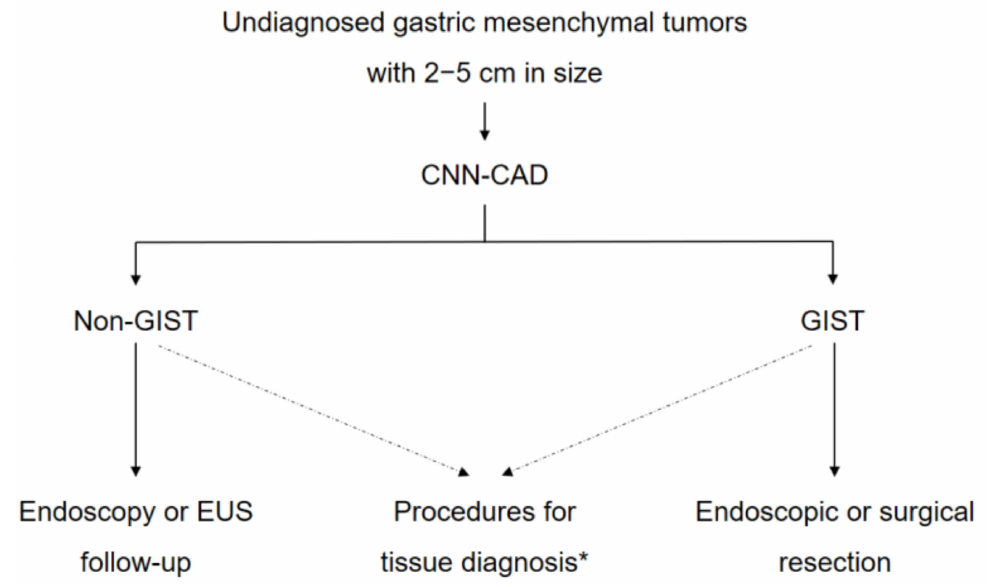
Figure 4. A suggested strategy based on the convolutional neural network computer-aided diagnosis system for gastric mesenchymal tumors of 2–5 cm in size. CNN-CAD, convolutional neural network computer-aided detection; EUS, endoscopic ultrasonography; GIST, gastrointestinal mesenchymal tumor. *EUS-guided or submucosal dissection-assisted